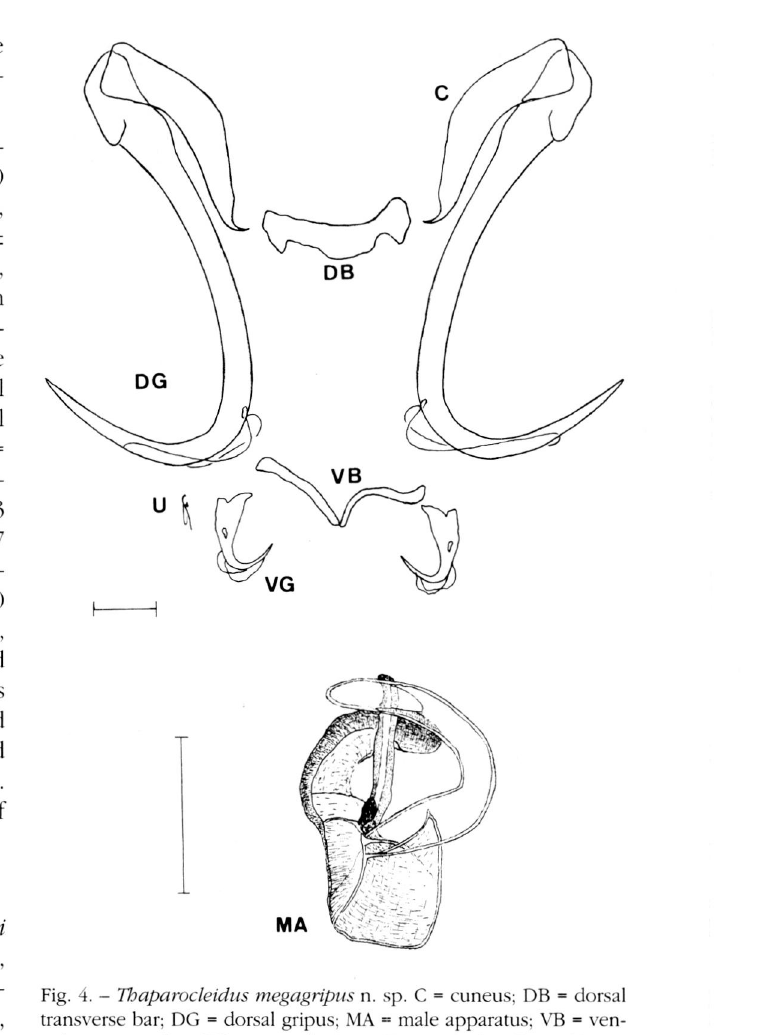
Fig. 4. - Thaparocleidus megagripus n. sp. C = cuneus; DB = dorsal transverse bar; DG = dorsal gripus; MA = male apparatus: VB = ven tral transverse bar; VG = ventral gripus; U = uncinulus. Bar = 30 um.